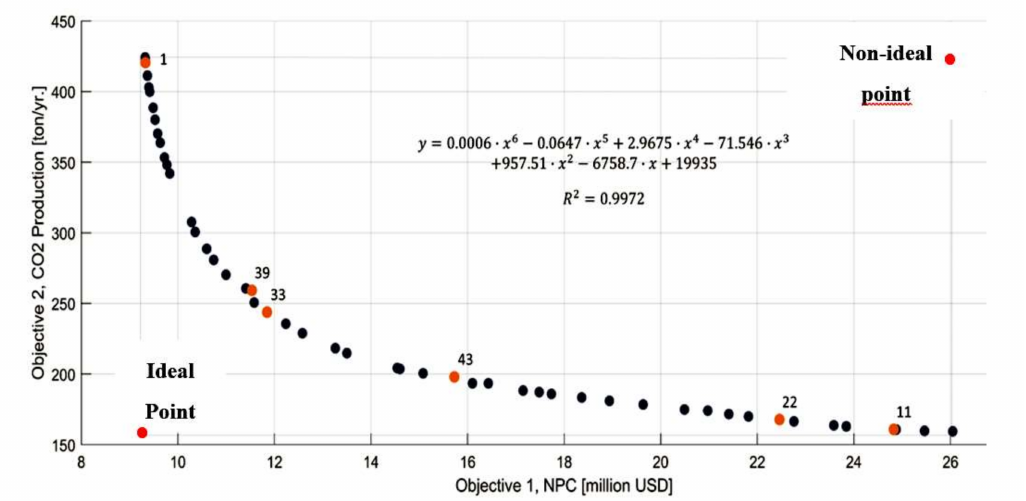
Figure 14. Pareto front for multi-objective optimization of NPC and CO 2 emissions.